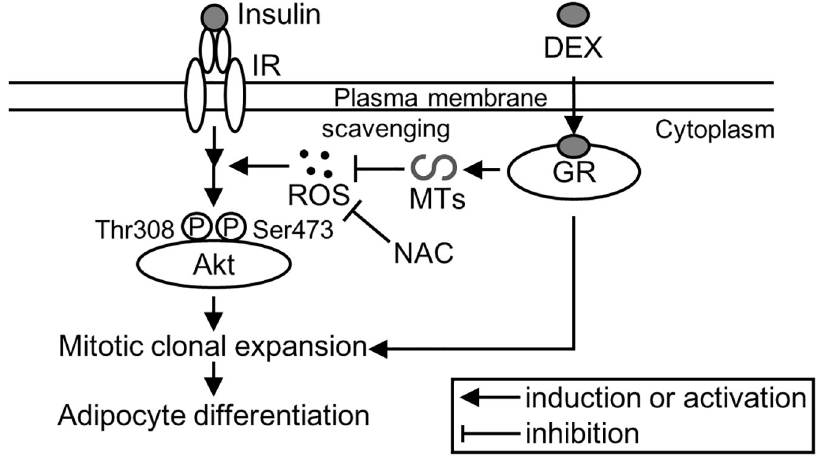
Fig 9. Scheme of a potential mechanism for the regulation of the insulin/Akt signaling pathway by MTs. The adipogenic differentiationof 3T3-L1 preadipocytes into adipocytesis inducedwith differentiation- inducingmedium (DIM) containing insulin, dexamethasone (DEX), and IBMX. ROS activate insulin/Akt signaling and promote mitotic clonalexpansion. Metallothioneins (MTs), which are inducedby DEX treatment, may regulateinsulin-Akt signalingby scavenging the ROS. IR, insulinreceptor; GR, glucocorticoid receptor.